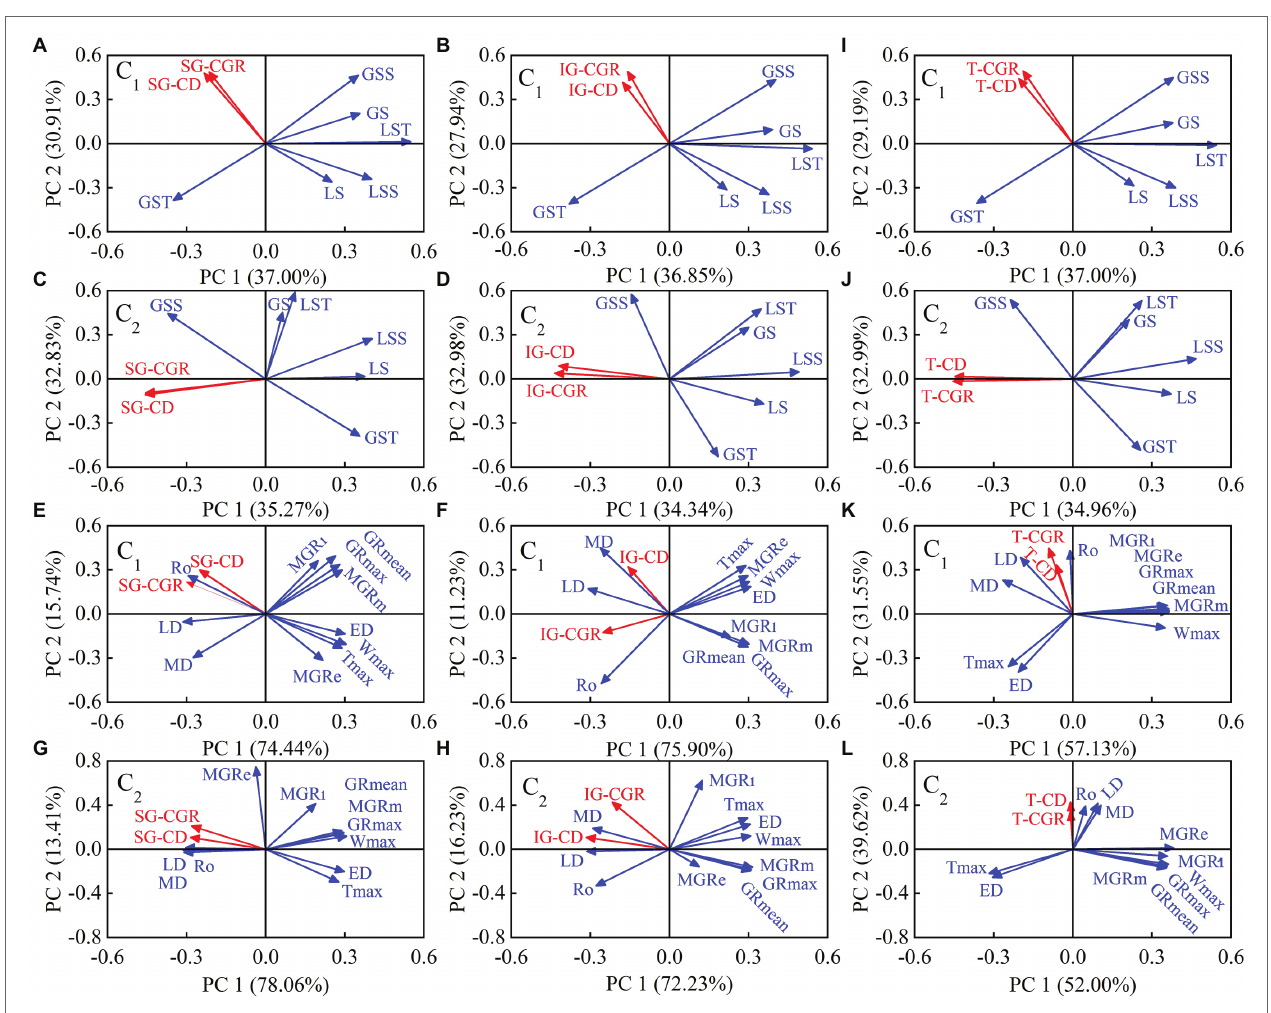
FIGURE 7 | Principal component analysis of chalky grain rate and chalkiness degree of superior and inferior grains (A–H) , as well as the total chalky grain rate and chalkiness degree (I–L) with carbohydrate or grain filling parameters under different N application rates, and the vectors represent the loading scores of variables for PC1 and PC2. PC1: principal component 1; PC2: principal component 2; C 1 : Chuannongyou 508; C 2 : Shuangyou 573; SG-CGR: superior grain chalky grain rate; SG-CD: superior grain chalkiness degree; IG-CGR: inferior grain chalky grain rate; IG-CD: inferior grain chalkiness degree; T-CGR: total chalky grain rate; T-CD: total chalkiness degree; GSS: grain soluble sugar; GS: grain sucrose; GST: grain starch; LSS: leaf soluble sugar; LS: leaf sucrose; LST: leaf starch; R 0 : initial growth potential of grain;